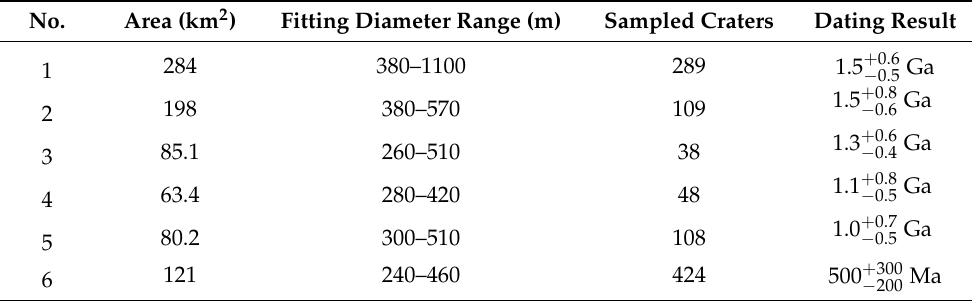
Table 1. Dating results of layered ejecta in the MFF. The numbers (No.) correspond to those in Figures 4 and 5. The fitting diameter range refers to those fitting with the chronology curve, and the sampled craters are the numbers of all the mapped craters in each layered ejecta. No. Area (km 2 ) Fitting Diameter Range (m) Sampled Craters Dating Result